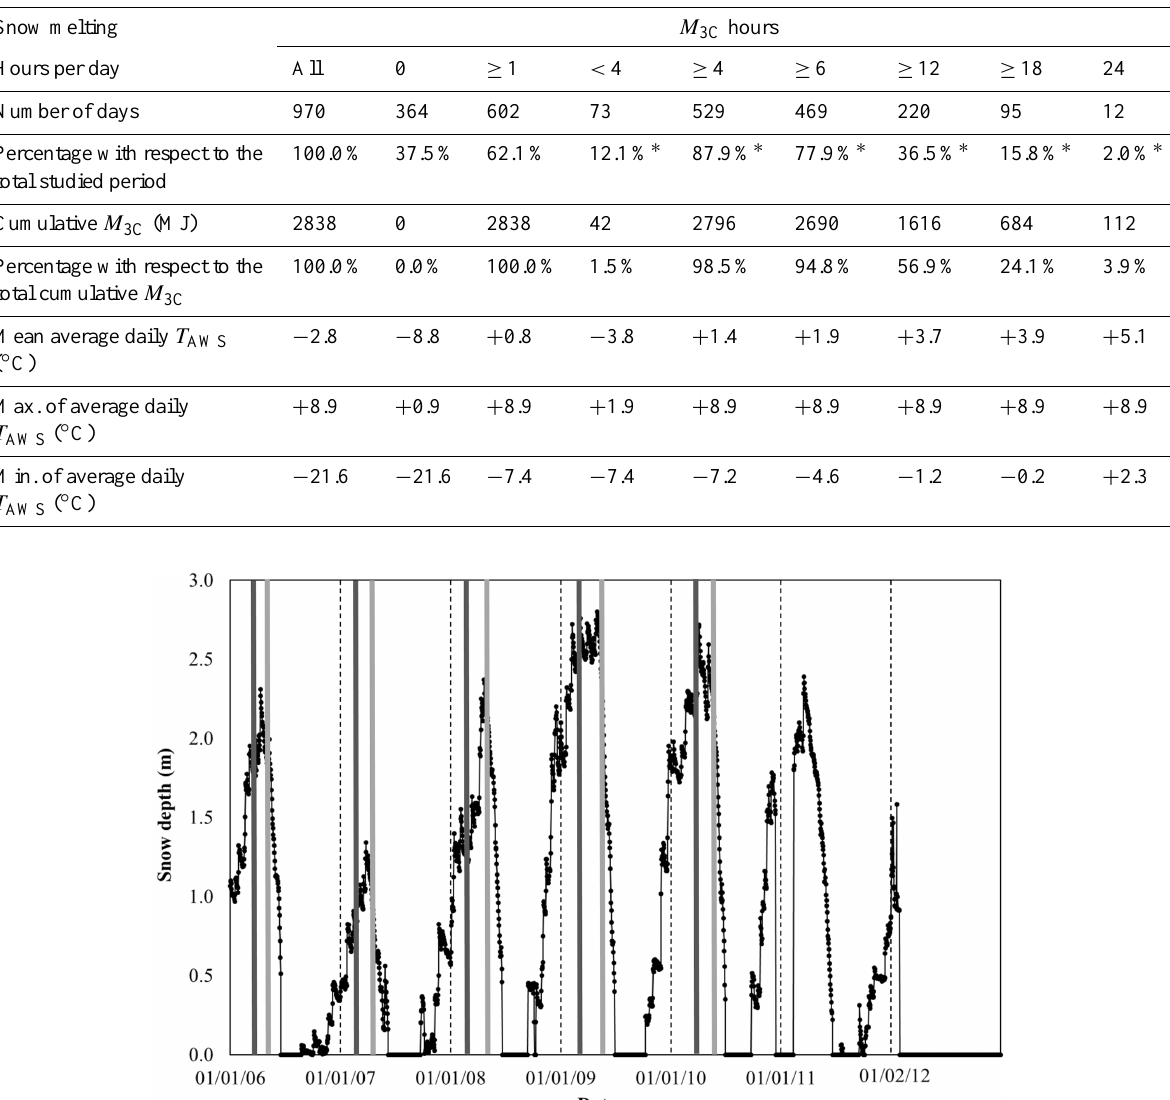
Table 2. Number of days, cumulative energy budget ( M 3C ) and daily temperature values (mean, maximum and minimum of the average data) during the snow melting season from 2006 to 2012 considering different temporal length classes of M 3C hours per day. The percentage values with an asterisk refer to a period featuring melting (i.e., at least 1 M 3C hd − 1 ). The air temperature data are recorded by AWS1 Forni ( T AWS ).